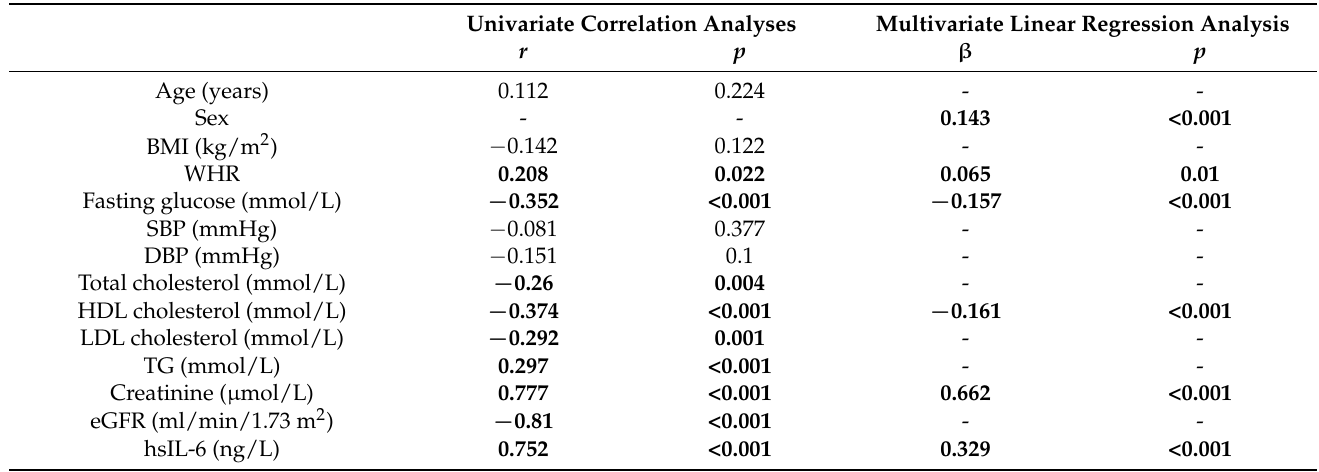
Table 2. Univariate correlations and multivariate linear regression analysis of serum sThy1 with anthropometric parameters and markers of glucose metabolism, serum lipids, inflammation, and renal function in cohort 1 (N =